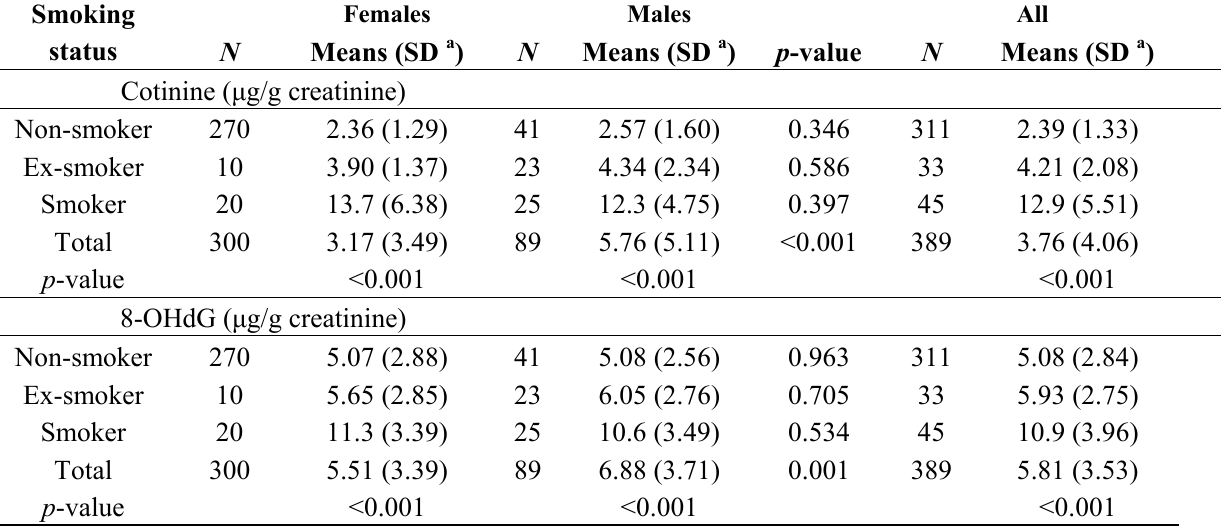
Table 1. Means and standard deviations of urinary cotinine and 8-hydroxydeoxyguanosine (8-OHdG) levels measured for office employees by smoking status and gender.